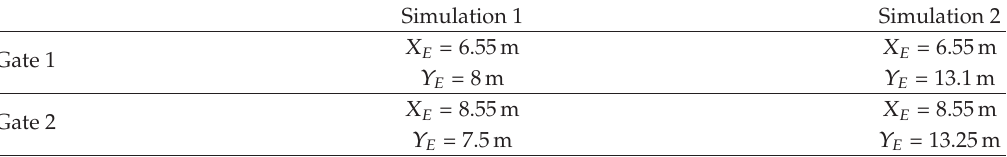
Table 5: Impact location for the